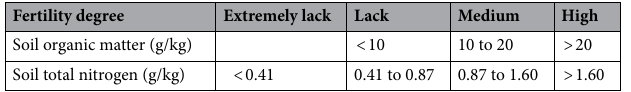
Table 6. Soil organic matter and Soil total nitrogen degrees.